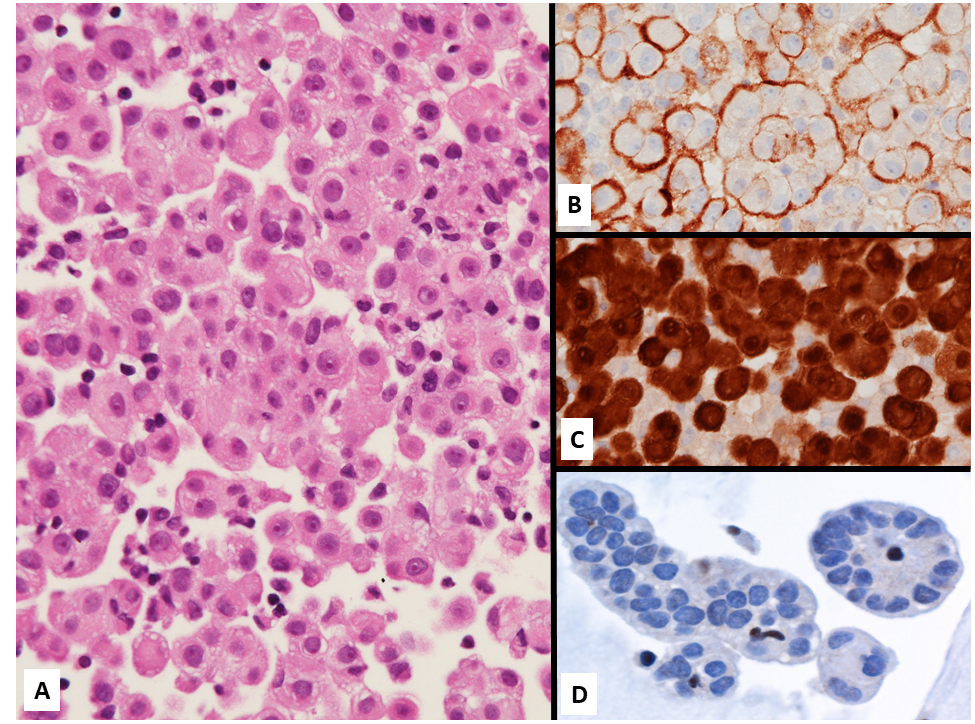
Figure 14. Epithelioid malignant mesothelioma on cell-block from pleural effusion showing numerous atypical cells focally forming papillary structures ( A ) expressing D2-40 ( B ) and calretinin ( C ) with loss of BAP1 staining ( D , note some normally positive inflammatory cells among malignant cells).